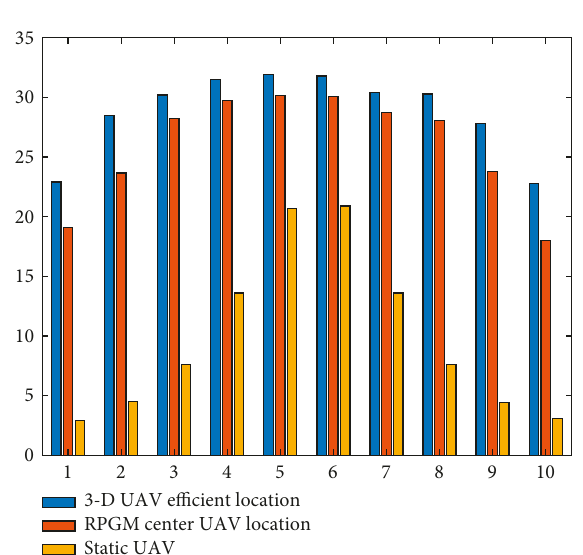
Figure 5: Users average sum rate over different time slots for 3 UAV placement approaches efficient, RPGM center and static.